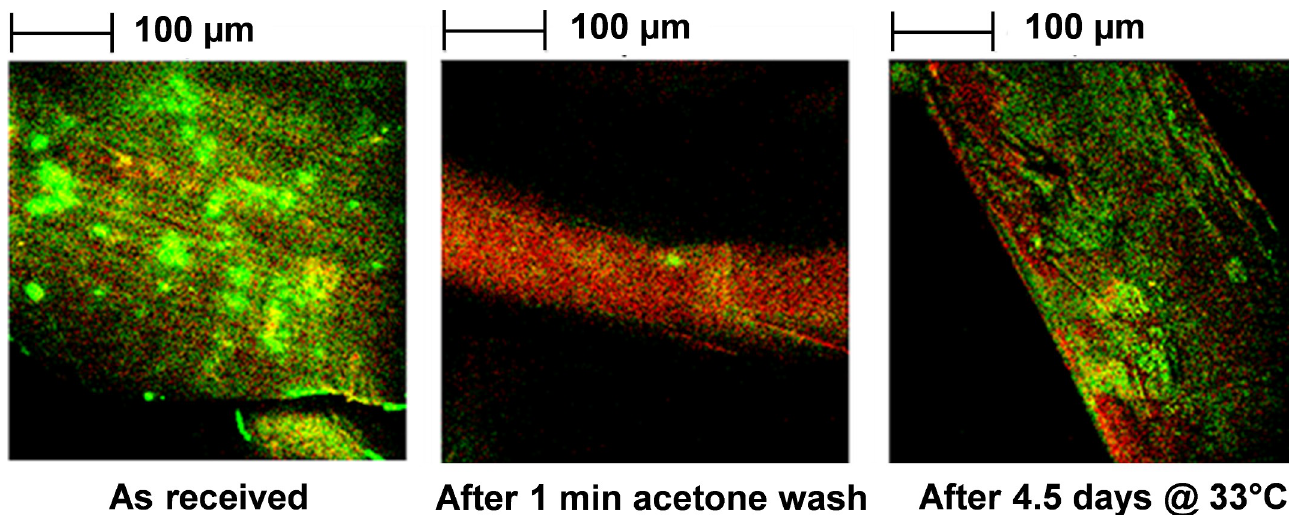
Fig 4. ToF-SIMS negative ion high spatial resolution images showing 35 Cl - distribution on Olyset fiber surfaces as received, after acetone wash, and after incubation for 4.5 days at 33˚C. Chlorine regions are shown in green. Analysis area of each location is 400 μ m × 400 μ m.